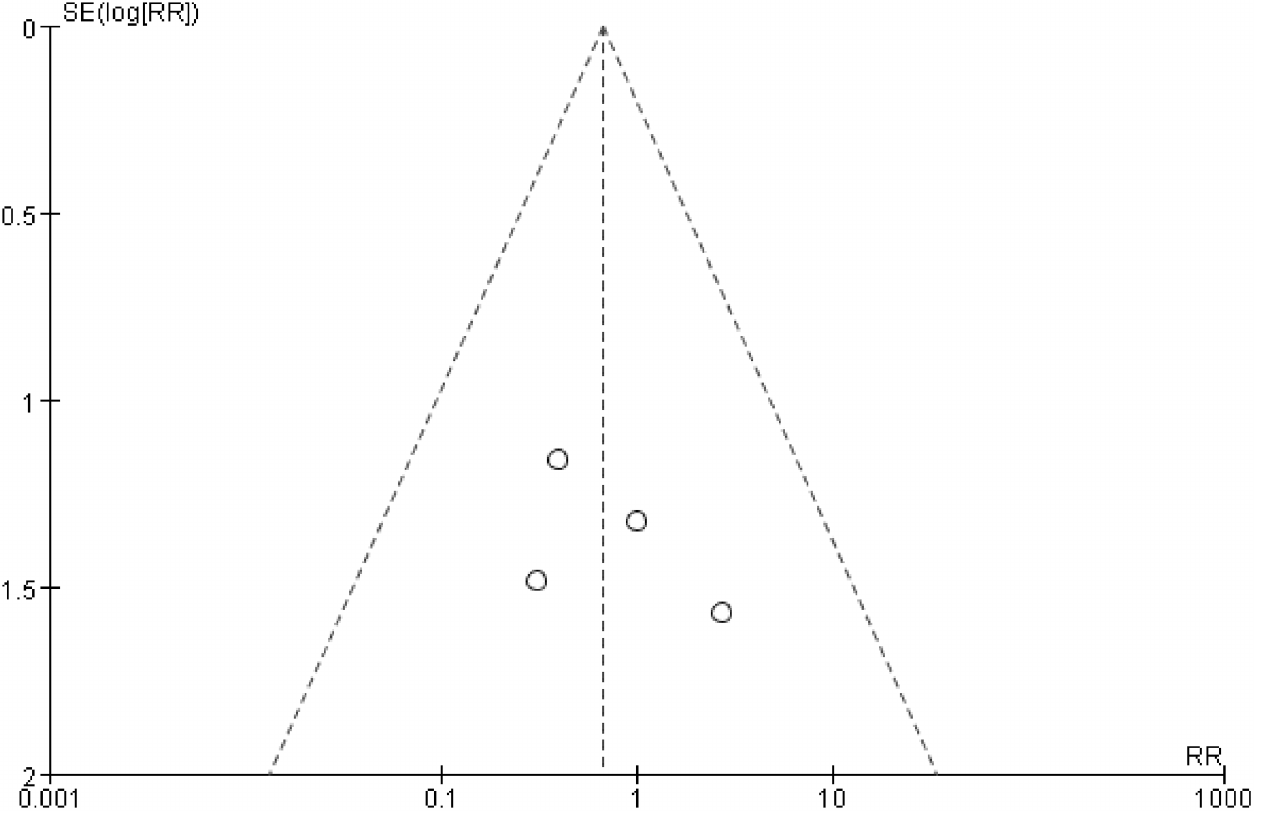
Fig 6. Funnel plot of the occurrences of reankylosis in GA and IA (TMF) groups, Egger ’ s test results: t = 0.91, p =